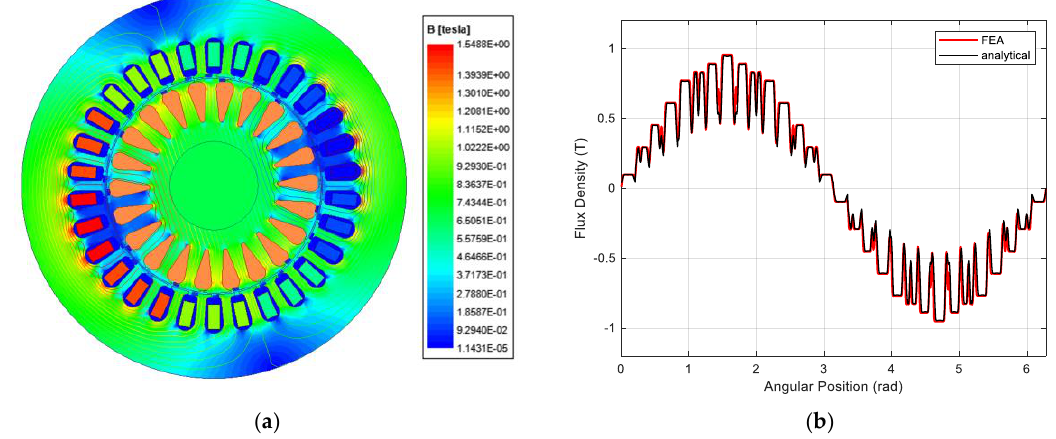
Figure 4. ( a ) No-load flux density distribution inside the machine, ( b ) air gap flux density.